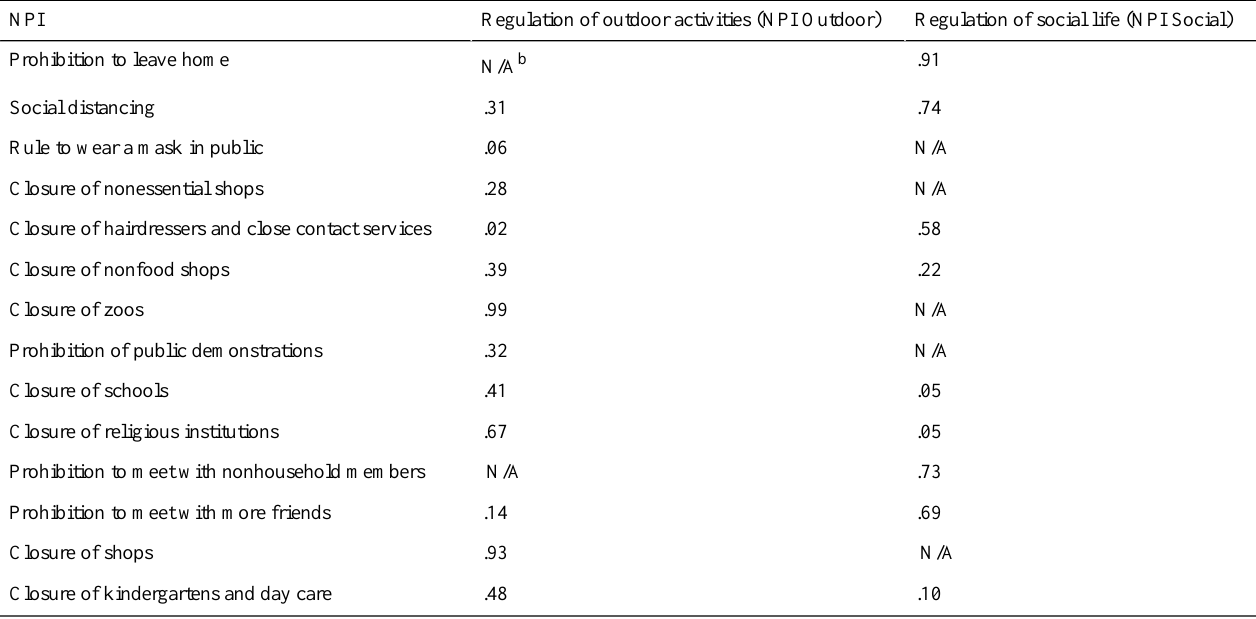
Table 2. TSFA loadings for the two extracted NPI factors, regulation of outdoor activities (NPI Outdoor) and regulation of social life (NPI Social), for aggregated time series data a